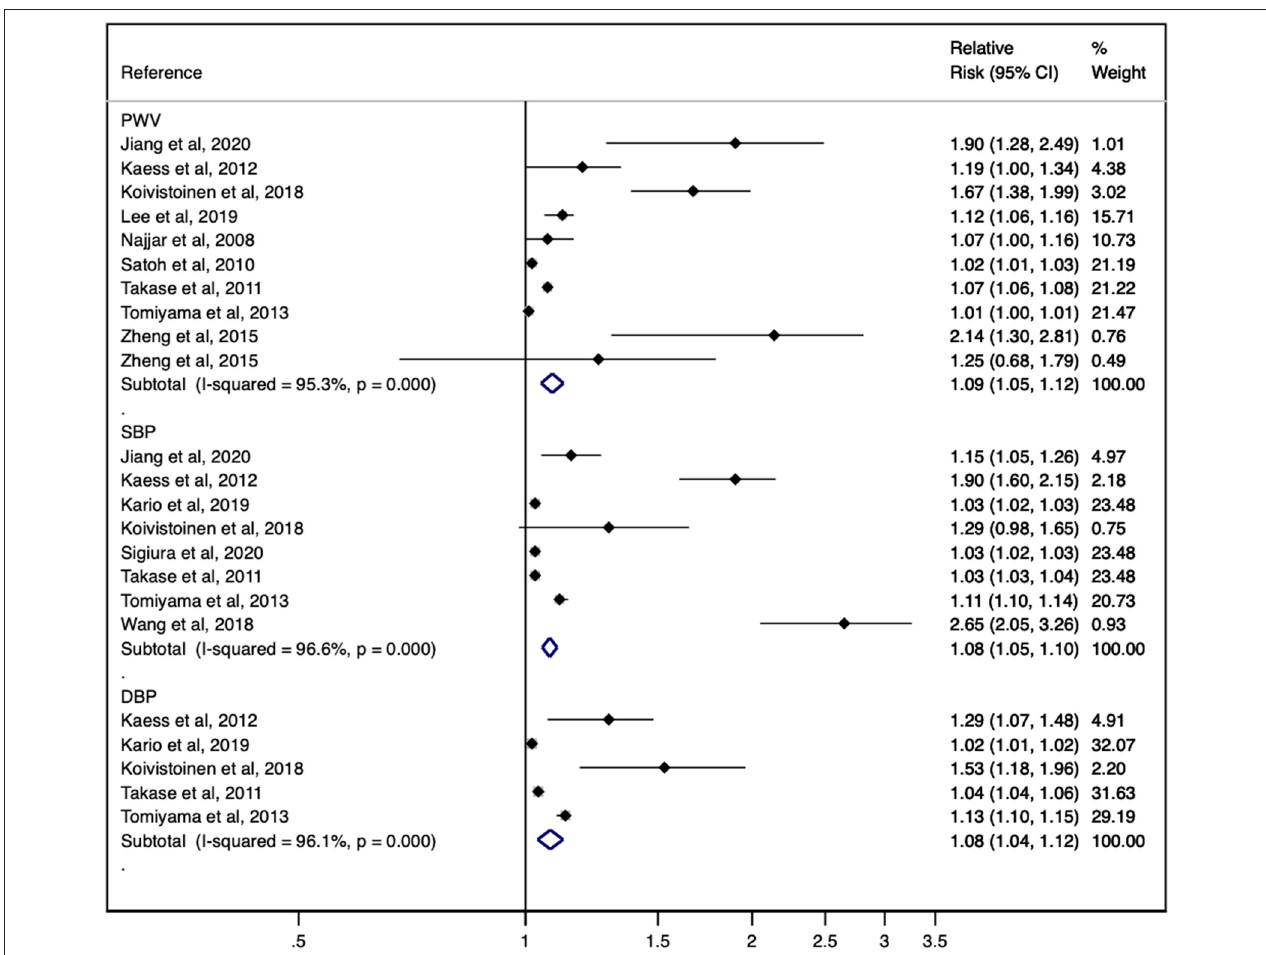
FIGURE 2 | Forest plot including the relative risk of incident hypertension for pulse wave velocity, systolic blood pressure and diastolic blood